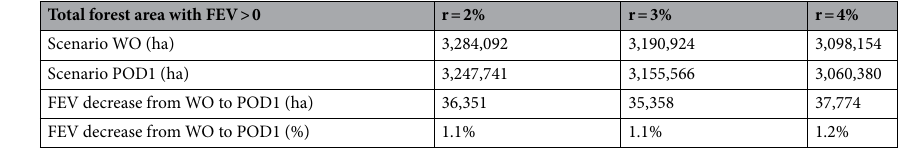
Table 2. Total forest area (ha) with FEV > 0 and its decrease under no ozone damage scenario (WO) and phytotoxic ozone dose (POD1) scenario. Results are for the Italian forests in 2005, with different interest rates r.